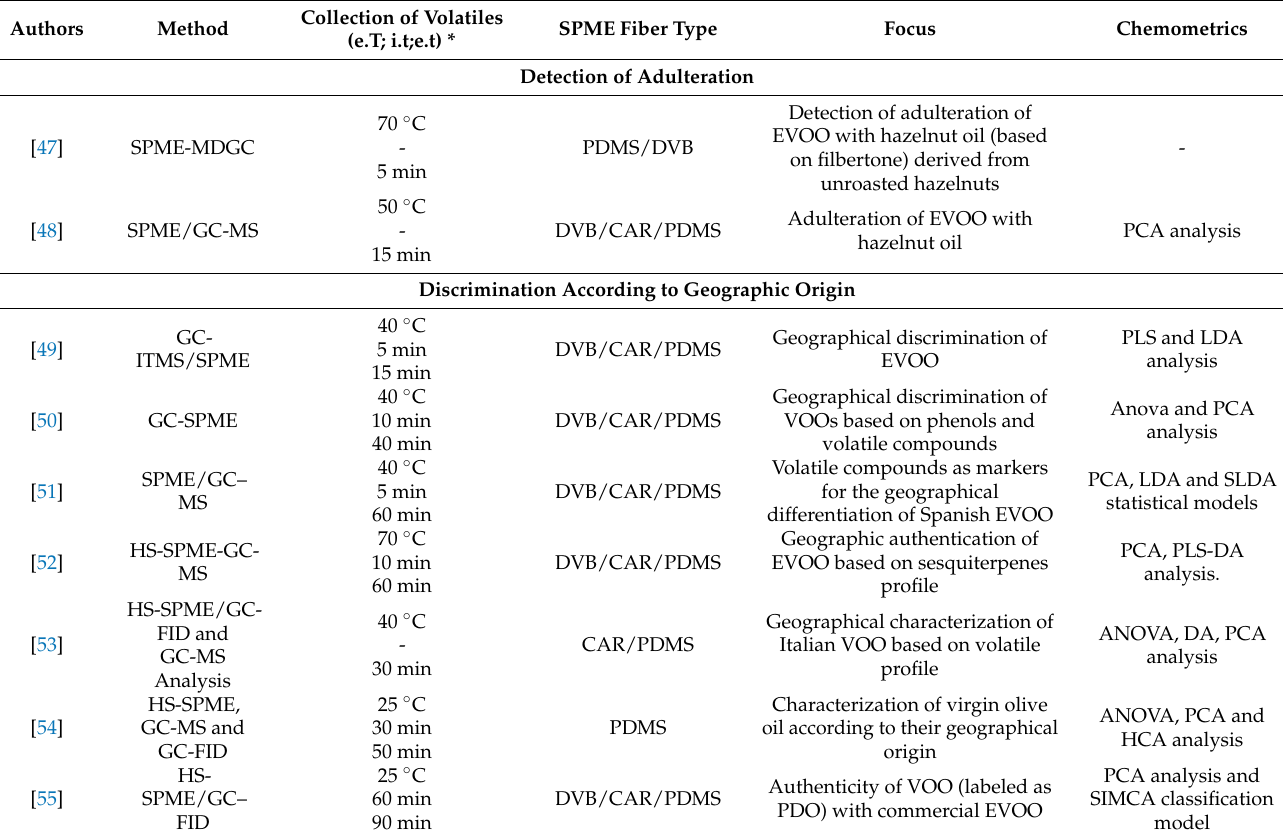
Table 2. Gas chromatography and volatile profile to evaluate authenticity of EVOO and